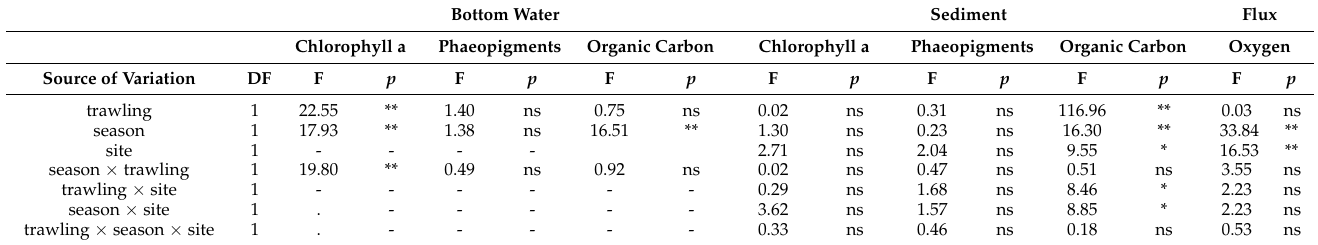
Figure 4. Oxygen flux rates (micromole per square metre per hour) from the trawled and untrawled sampling sites with mean and standard deviation in summer and winter. Grey bars indicate the eastern sites and white bars the western sites.